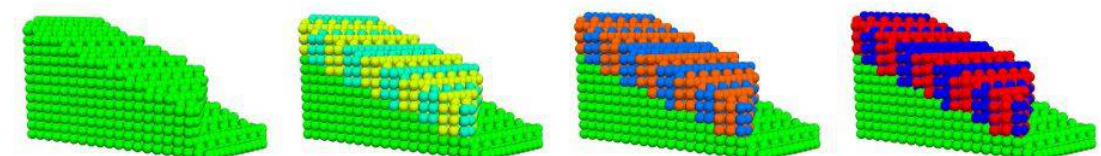
Figure 24. Continuous distortion model of the fcc-bcc transformation on a (225) habit plane. This plane, which is only untilted during the formation of one variant, becomes an IPS when two twin-related KS variants are formed together. The atoms of the fcc crystal are in green, and those of the two final twin-related bcc variants are in red and blue. Movie available at https://www.nature.com/article-assets/npg/srep/2017/170120/srep40938/extref/srep40938-s1.avi. From [124].